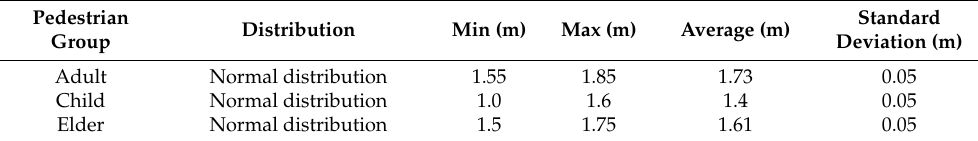
Table 1. The height parameters of the simulated pedestrian.